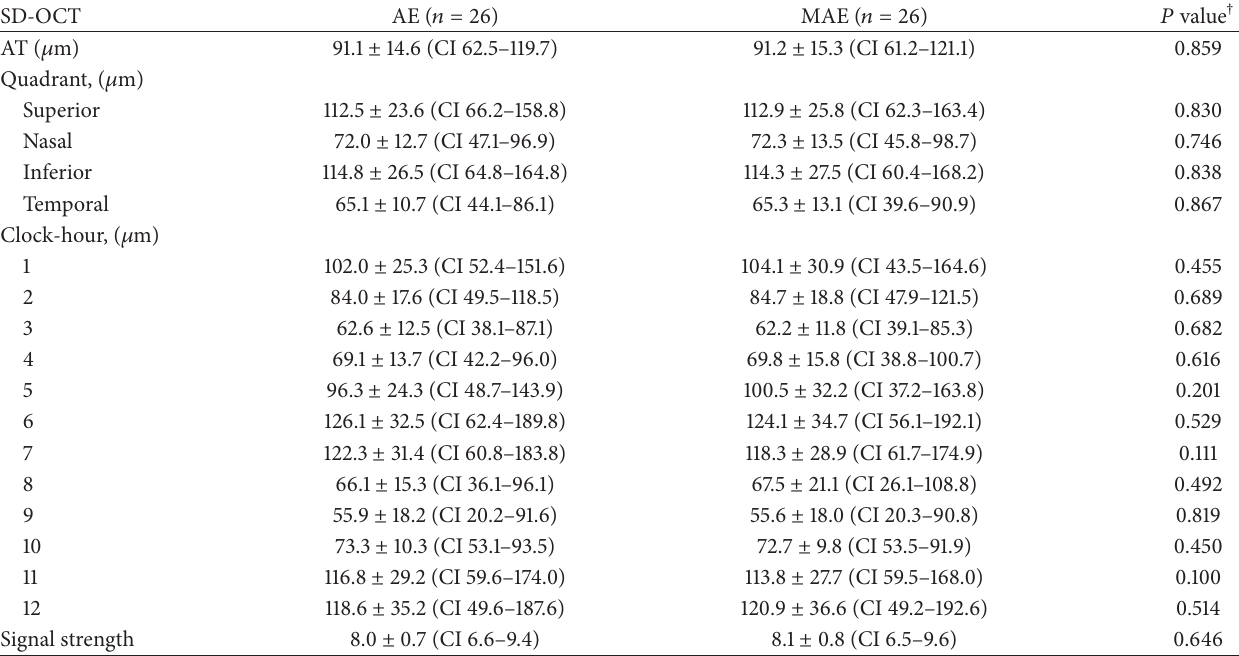
Table 4: Comparison of mean ± standard deviation (95% confidence interval) SD-OCT parameters between eyes with and without misalignments in the inferior area (sectors 3 and 4).